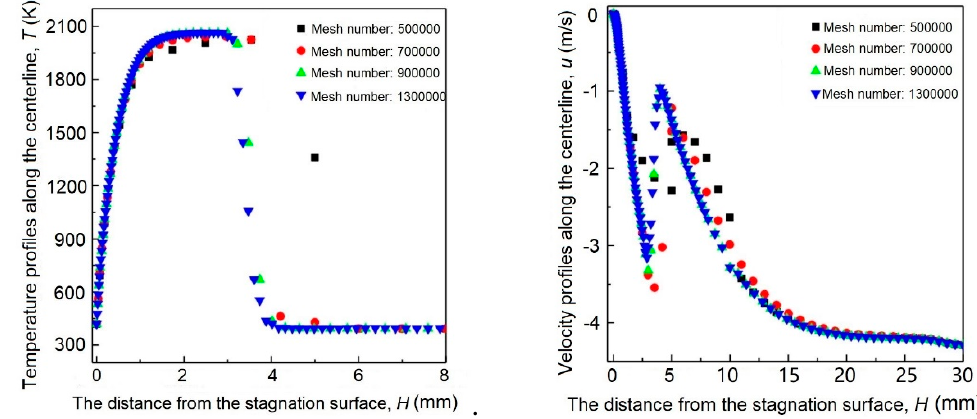
Figure 3. Mesh independence test: ( a ) Temperature profiles along the centerline of the flame at different mesh number; ( b ) velocity profiles along the centerline of the flame at different mesh number.